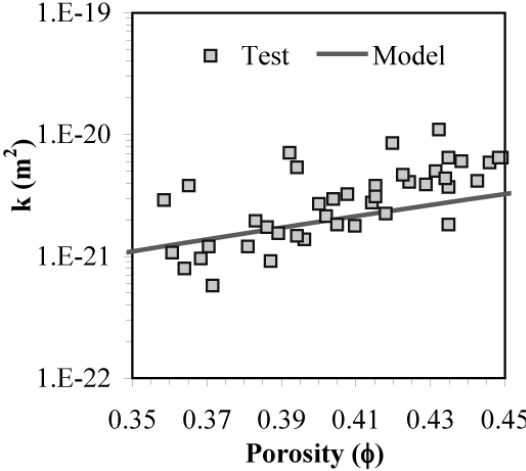
Fig. 3 – Variation of saturated permeability with porosity. Experimen- tal data and adopted model for the intrinsic permeability